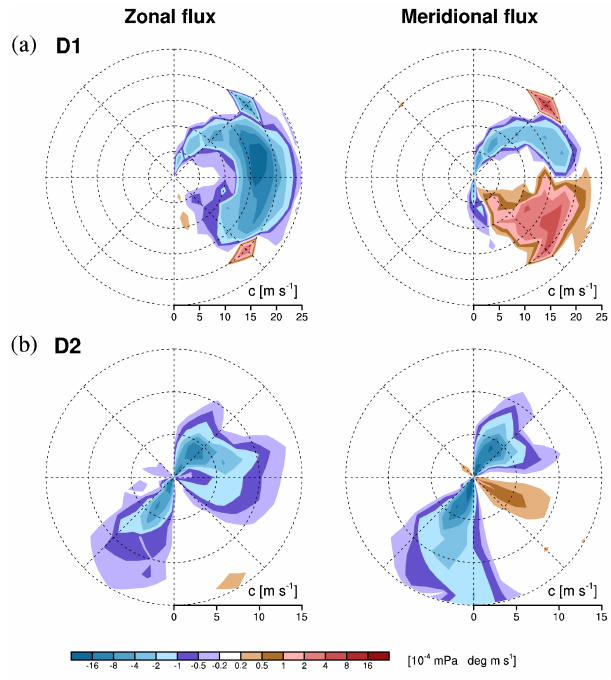
Figure 10. (left) Zonal and (right) meridional momentum flux spec- tra at z = 8km as a function of phase speed and propagation direc- tion calculated in (a) 48–73 ◦ N, 20–60 ◦ E and (b) 21–46 ◦ N, 20– 60 ◦ E. (e.g., Zhang, 2004, and PS07). Possible reasons for this